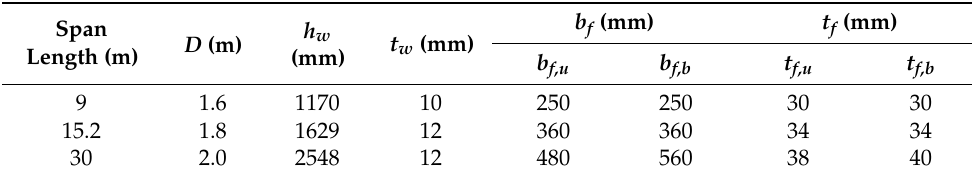
Table 4. Section properties of open-deck steel plate girder bridge calculated by 3D FE analysis.